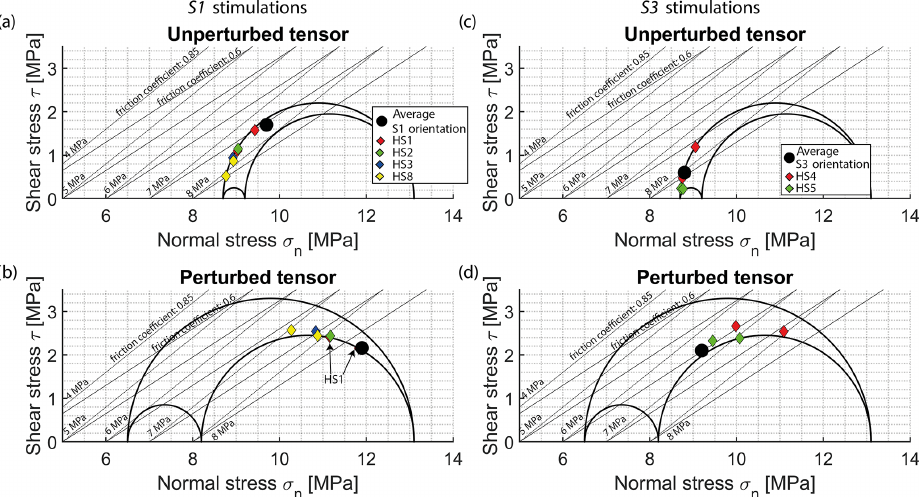
Figure 3. Stress states associated with the perturbed and unperturbed tensors for S1 and S3 shear zones. The implied average shear and normal stresses acting on the S1 and S3 shear zones (estimated over all mapped borehole intersections of these shear zones) are indicated in black. Also shown are the shear and normal stress acting on the principal fractures imaged in the S1 and S3 intersections with INJ boreholes. Additionally, a range of injection pressures is indicated as a black-lined failure criterion with different friction